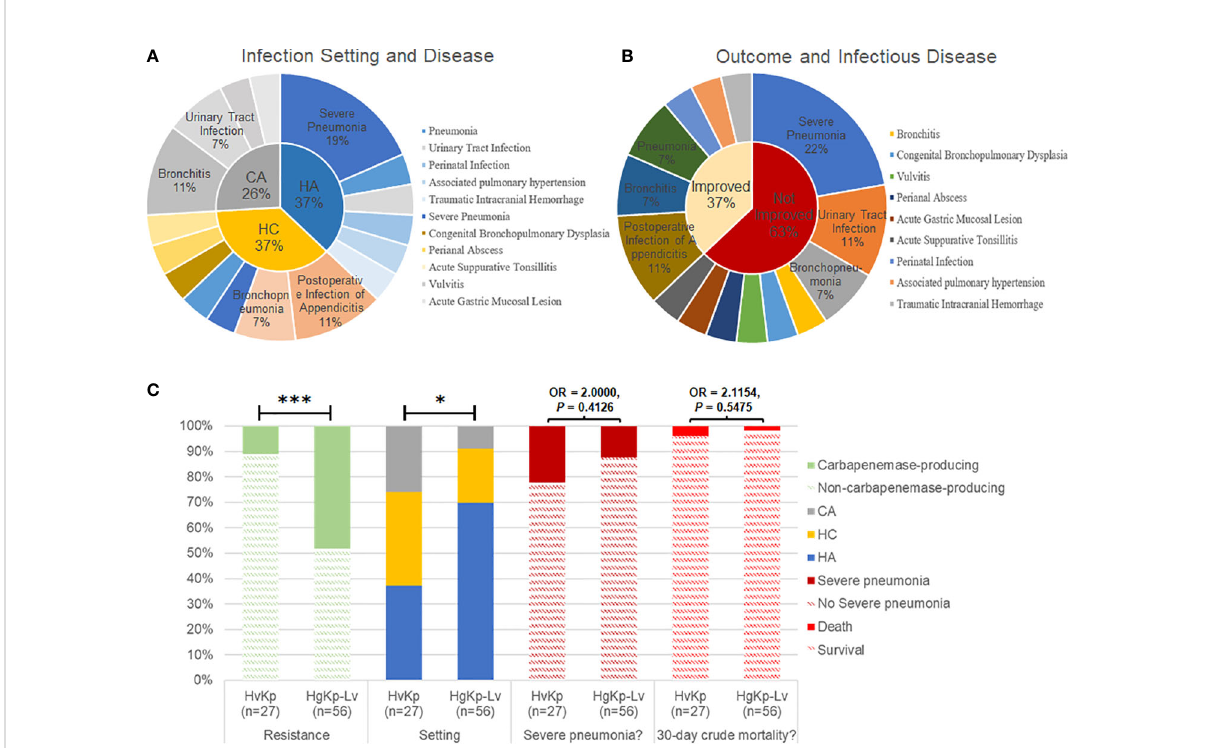
FIGURE 5 Clinical manifestations of hvKp infection in children. (A) Infection setting of hvKp. CA, community-acquired infection; HC, healthcare-associated infection; HA, hospital-acquired infection. (B) Outcomes and associated infectious diseases in children with hvKp infection. Outcomes were assessed in terms of prognosis and recurrence during follow-up. (C) Comparison of clinical features between hvKp infections and hgKp-Lv infections. Odds ratios (OR) and P -values are shown for relevant results. P < 0.05 (*) and P < 0.001